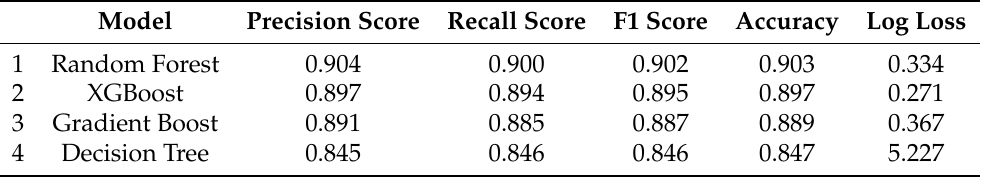
Table 3. Performance of models before pruning